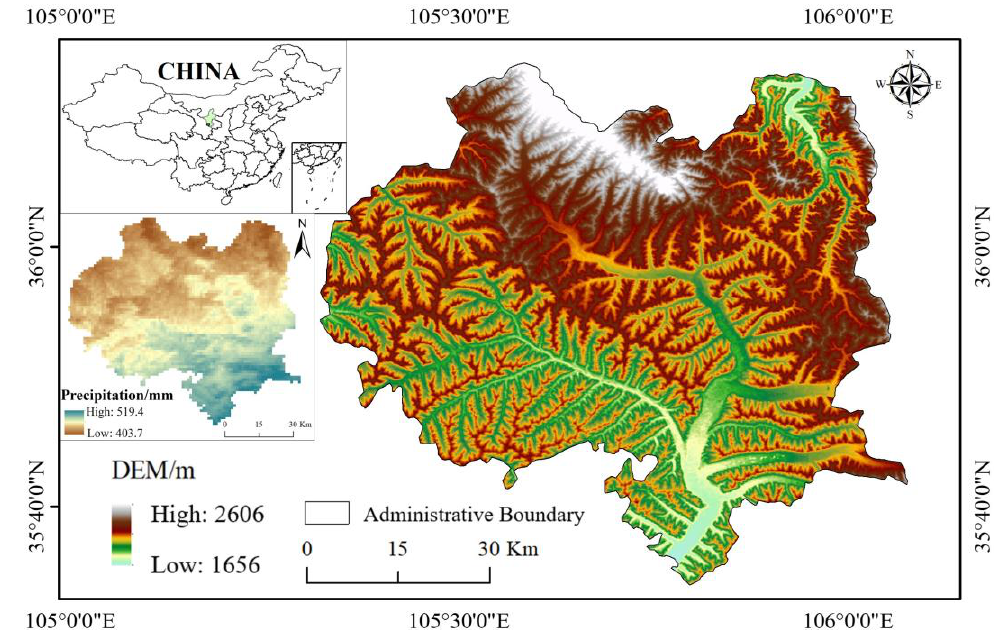
Figure 1. Location map of Xiji